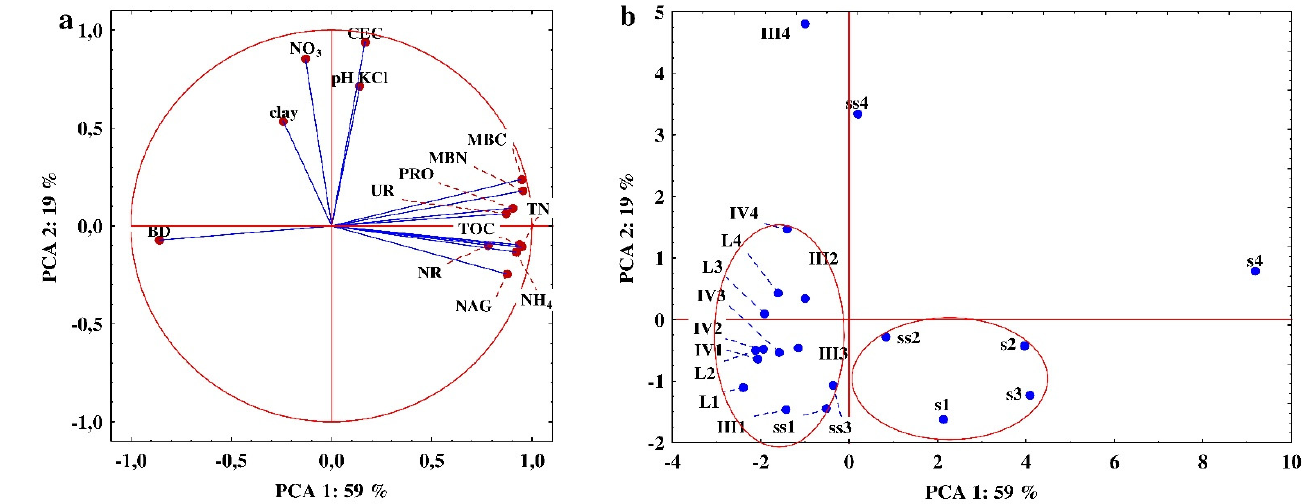
Figure 7. Principal component analysis derived from the studied soil properties. ( a ) Plot of the first two principal components (PC) for the measured soil properties, UR urease, NR nitrate reductase, PRO proteases, NAG N-acetyl-glucosaminidase, TOC total organic carbon, TN total nitrogen, MBC— microbial biomass carbon, MBN microbial biomass nitrogen, DB bulk density, N-NO 3 − nitrate nitrogen, N-NH 4+ ammonium nitrogen, CEC cation exchange capacity; ( b ) principal component analysis of the variables in the soil horizons in all 4 profiles: s1–s4 the surface (Ap) horizons, ss1 ss4 the sub-surface horizons, III1–III4 the middle (thirds) horizons, IV1–IV3 the second from the bottom horizons, L1–L4 the deepest horizons.